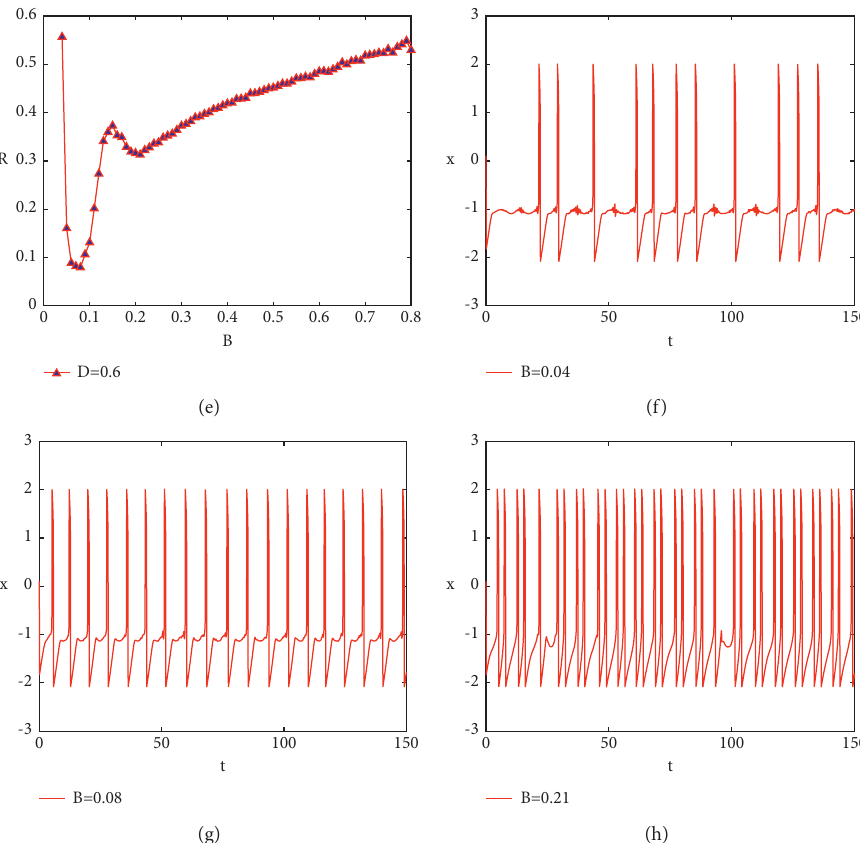
Figure 8: When the phase noise intensity changes, the plot of the coherence resonance coefficient R varying with phase noise amplitude B and the time evolution diagram of the system membrane potential x . (a)When D � 0 . 02, variation of R with B ; (b) D � 0 . 02, B � 0 . 05; (c) D � 0 . 02, B � 0 . 14; (d) D � 0 . 02, B � 0 . 7; (e)When D � 0 . 6, variation of R with B ; (f) D � 0 . 6, B � 0 . 04; (g) D � 0 . 6, B � 0 . 08; (h) D � 0 . 6, B � 0 .